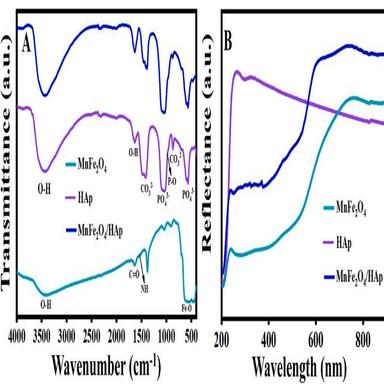
(A) FT-IR analysis and (B) UV–vis DRS spectra for prepared materials.